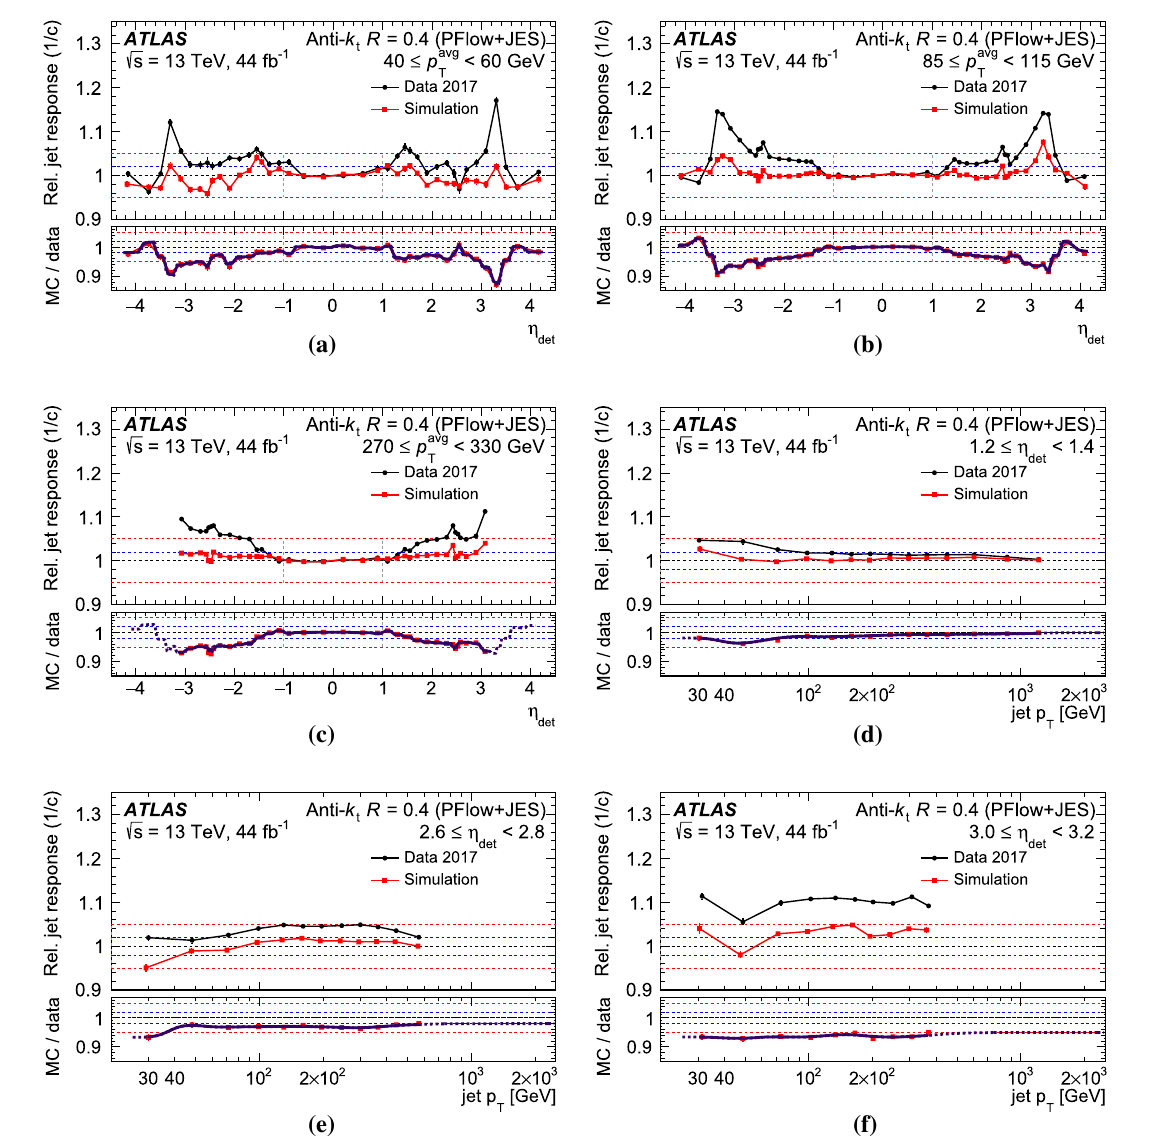
Fig. 9 Relative response of jets calibrated with PFlow+JES in data the response ratio of simulation to data (red squares) as well as the (black circles) and Powheg + Pythia 8 MC simulation (red squares). smoothed in situ calibration factor derived from the ratio (solid curve) < which is used to perform the η intercalibration. Dotted lines show the Response is shown as a function of η det for jets of a 40 GeV < p jet T extrapolationof the insitucalibrationtothe regions without data points. < 115 GeV, and c 270 GeV < p jet < 60 GeV, b 85 GeV < p jet T T The dashed red and blue horizontal lines provide reference points for 330 GeV, and as a function of p T for jets of d 1 . 2 < η det < 1 . 4, e the 2 . 6 < η det < 2 . 8, and f 3 . 0 < η det < 3 . 2. The lower panel shows